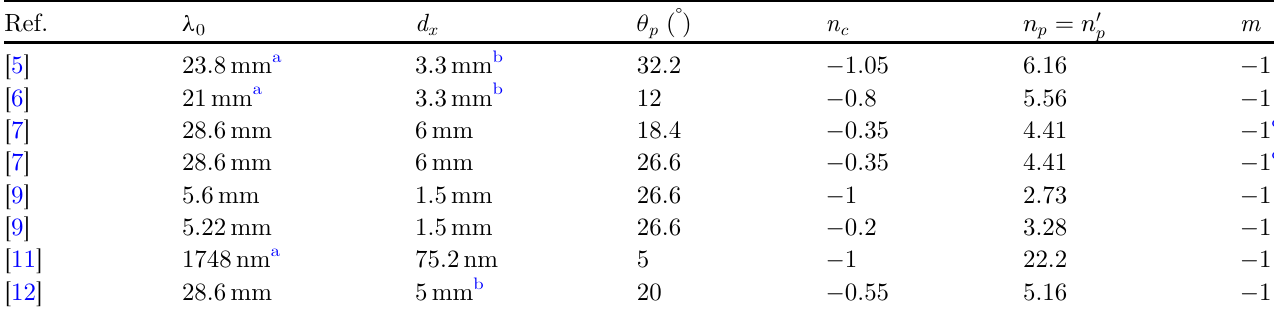
Table 1. Measurement con fi gurations for negative material design veri fi cation, and computed positive materials for producing the same negative refraction characteristics.